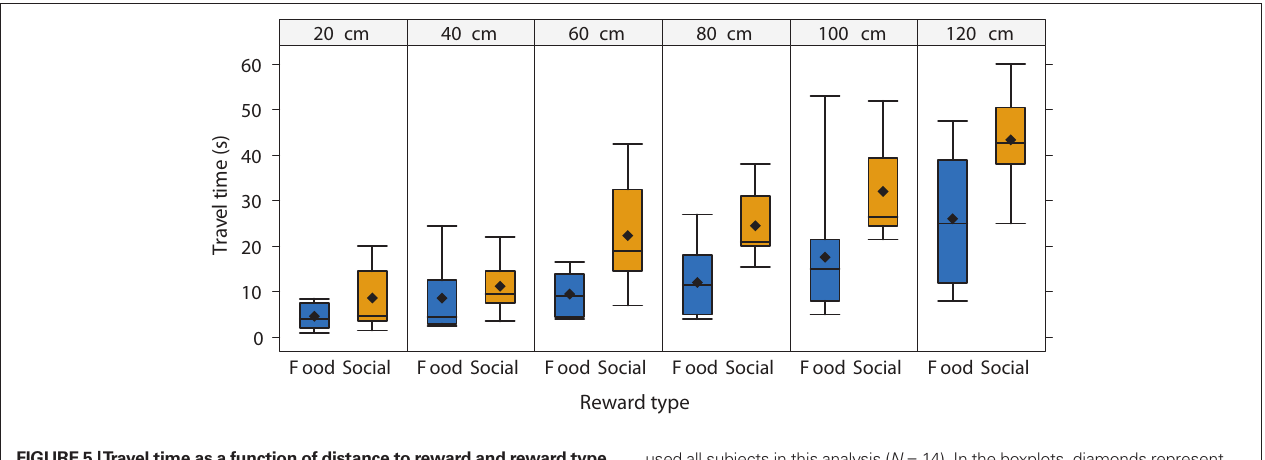
used all subjects in this analysis ( N = 14). In the boxplots, diamonds represent the mean, lines represent the median, boxes represent the interquartile range, and whiskers represent 1.5 times the